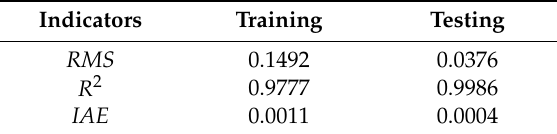
Table 6. The indicators of Training and Testing of Flexural strength ANN